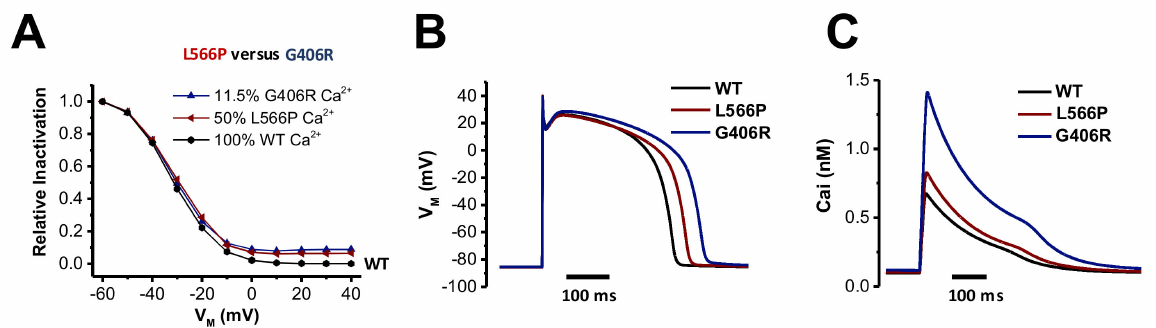
Figure 4. Stronger APD prolongation for the Timothy mutation Ca V 1.2 G406R compared to Ca V 1.2 L566P . ( A ) Model of the voltage dependence of inactivation of calcium currents in cardiomyocytes for heterozygous patients using the ten Tusscher and Panfilov variants for Ca V 1.2 G406R (blue) and Ca V 1.2 L566P (red), calculated with Ca 2+ as charge carrier. Indicted are the percentage of mutant Ca V 1.2 transcripts in the hearts of heterozygous patients. ( B ) In silico ventricular action poten- tial for Ca V 1.2 WT (black) or the heterozygous mutations Ca V 1.2 G406R (blue) and Ca V 1.2 L566P (red). ( C ) Corresponding intracellular Ca 2+ concentrations during ventricular action